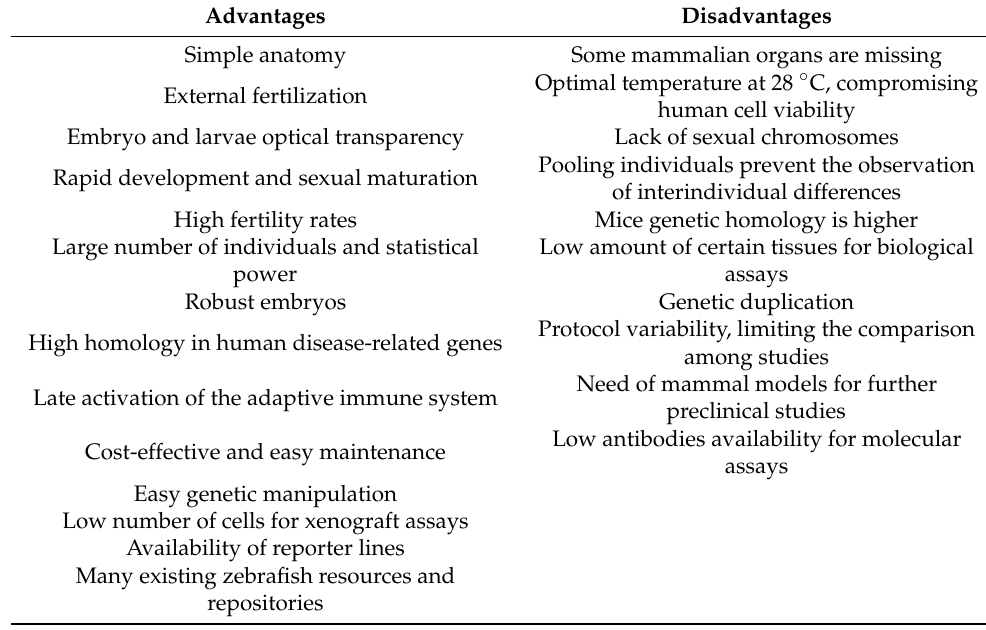
Table 1. Benefits and drawbacks of using zebrafish for modeling human diseases in comparison with other animal models. Advantages Disadvantages Simple anatomy Some mammalian organs are missing Optimal temperature at 28 ◦ C, compromising External fertilization human cell viability Embryo and larvae optical transparency Lack of sexual chromosomes Pooling individuals prevent the observation Rapid development and sexual maturation of interindividual differences High fertility rates Mice genetic homology is higher Large number of individuals and statistical Low amount of certain tissues for biological power assays Robust embryos Genetic duplication Protocol variability, limiting the comparison High homology in human disease-related genes among studies Need of mammal models for further Late activation of the adaptive immune system preclinical studies Low antibodies availability for molecular Cost-effective and easy maintenance assays Easy genetic manipulation Low number of cells for xenograft assays Availability of reporter lines Many existing zebrafish resources and